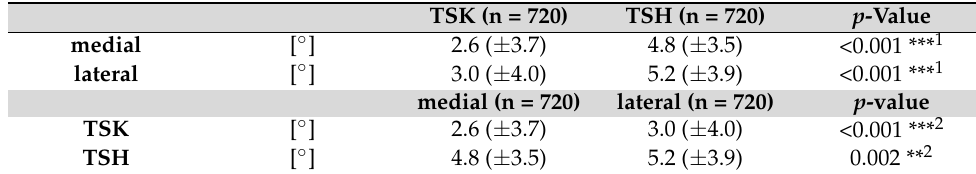
Table 1. Analysis of differences between TSK and TSH as well as between medial and lateral articular surface (*** p < 0.001, ** p < 0.01). TSK (n = 720) TSH (n =